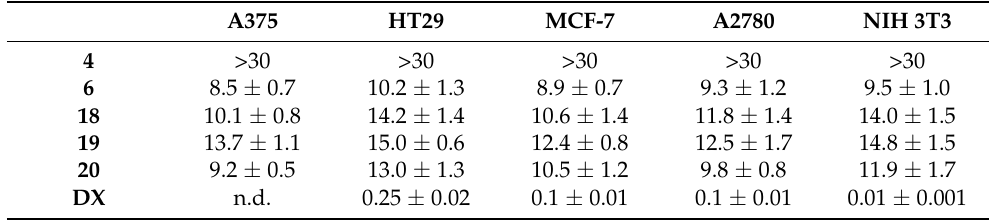
Figure 3. Dixon plot for compound 6 and CA II. Table 3. Cytotoxicity of acetazolamide ( 4 ) and conjugates 6 , 18-20 assessed from SRB-assays (EC 50 values [ µ M] after 72 h of treatment). Human cancer cell lines: A375 (epithelial melanoma), HT29 (colorectal adenocarcinoma), MCF-7 (breast adenocarcinoma), A2780 (ovarian carcinoma); non- malignant: NIH 3T3 (fibroblasts); n.d. not determined; positive control: doxorubicin ( DX